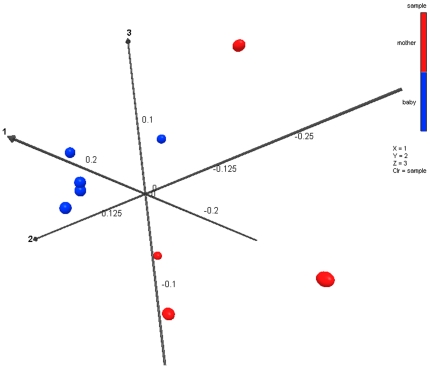
Principal component analysis of UNIFRAC distance metric.This figure provides a 3 dimensional visualization of the PCA analysis using the top 3 vectors. Red balls representing the mother samples and blue balls representing the baby samples clearly show the significant clustering distance between the two groups. Eigenvalues and % variation explained by each vector are Vector 1 eigval = 0.211 (41.5%), Vector 2 = 0.137 (26.8%), and Vector 3 0.061 (12%).